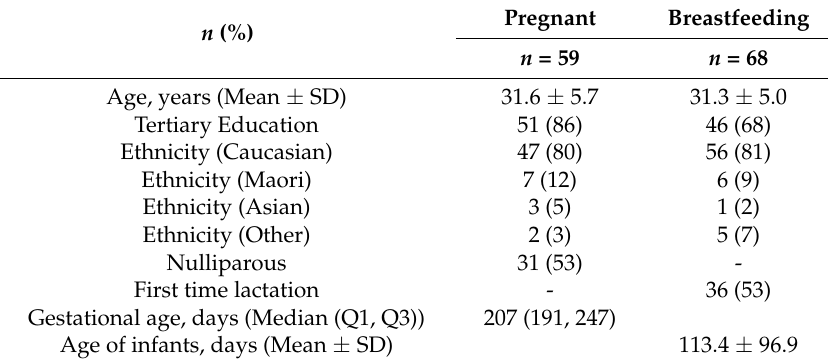
Table 1. Description of pregnant and breastfeeding participants.